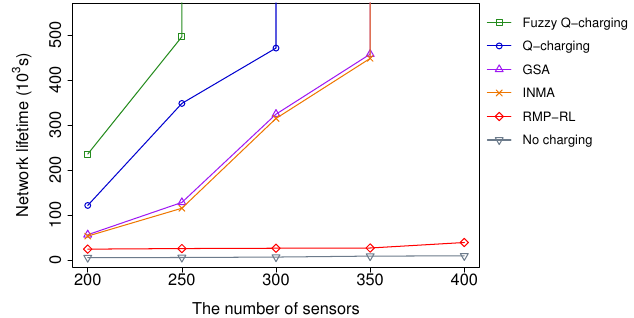
Figure 7. Network lifetime vs. the number of